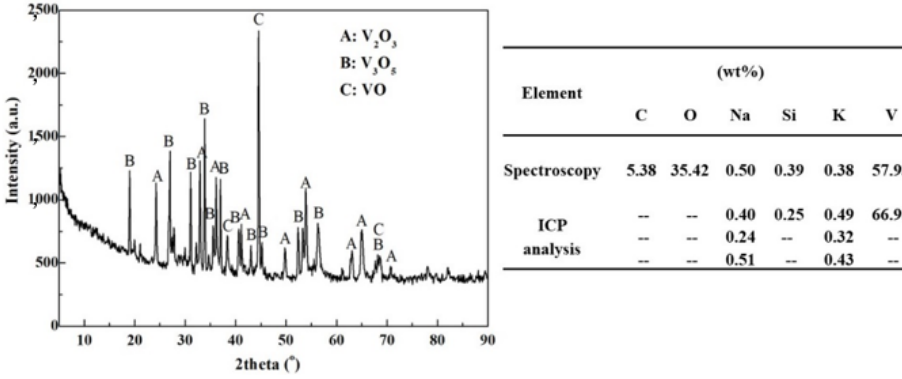
Figure 5. Phase composition analysis and element content analysis results of vanadium trioxide.